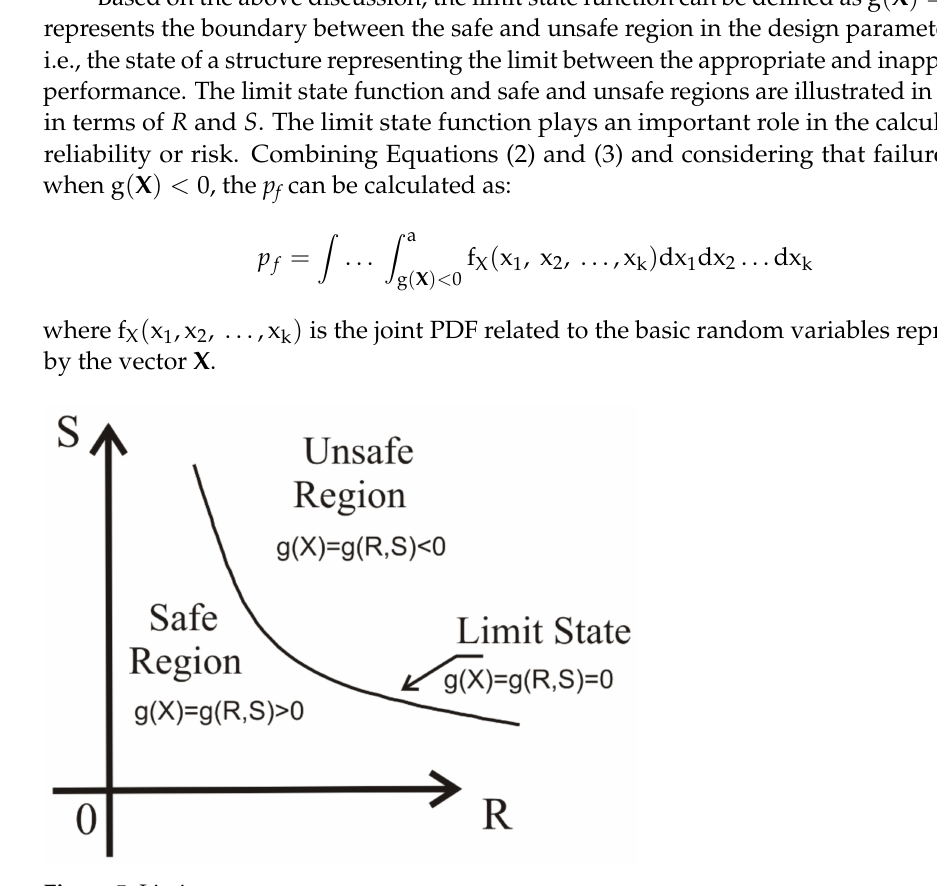
Figure 5. Limit state